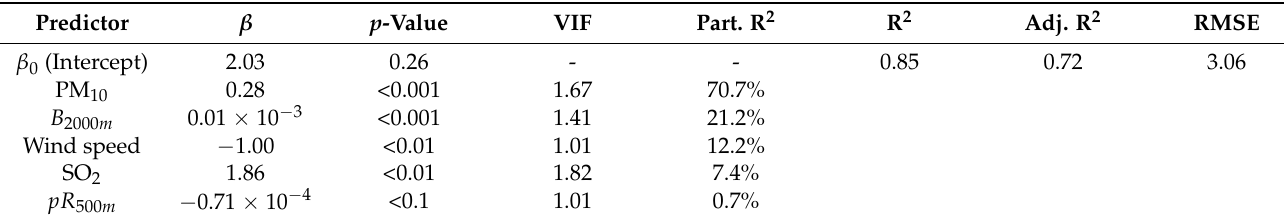
Table 4. Coefficient of predictors in the final model for PM 2.5 concentrations